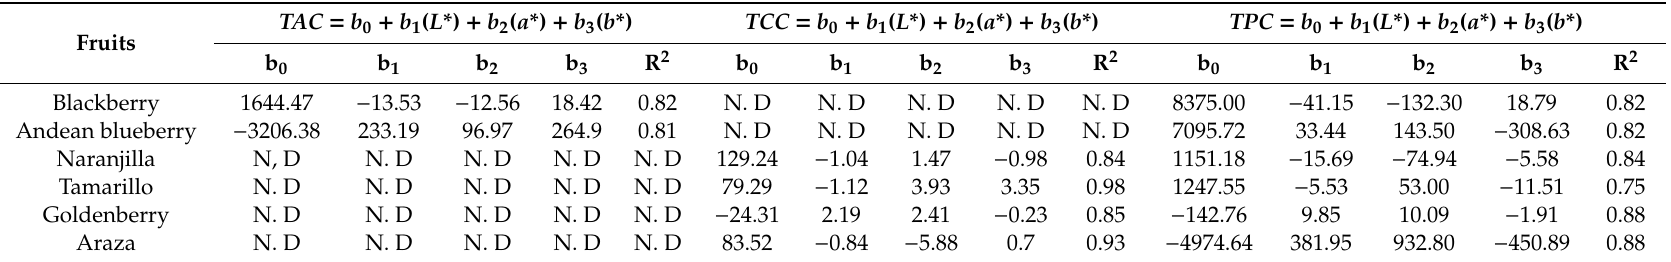
Table 4. Mathematical prediction models for total anthocyanin content (TAC), total carotenoid content (TCC) and total polyphenol content (TPC) of six tropical and Andean fruits from Ecuador.